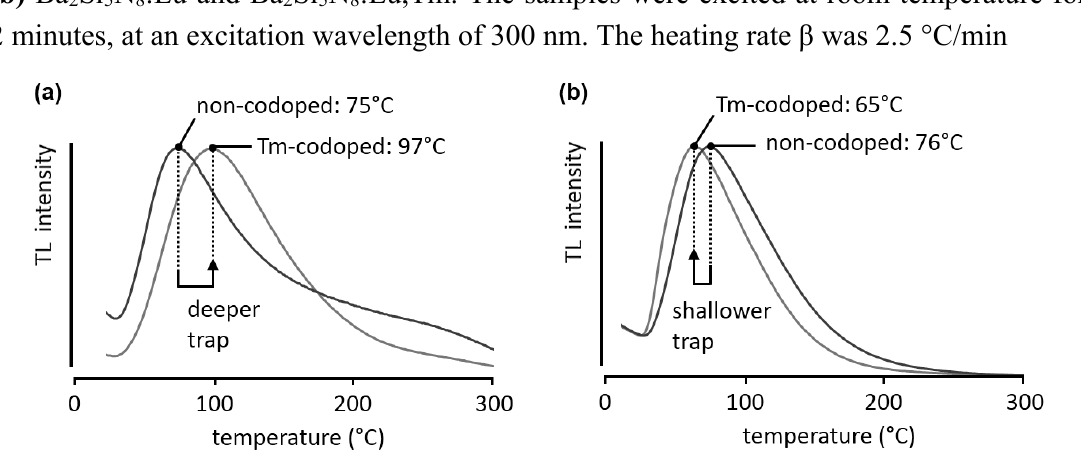
Si N :Eu,Tm; 2 5 8